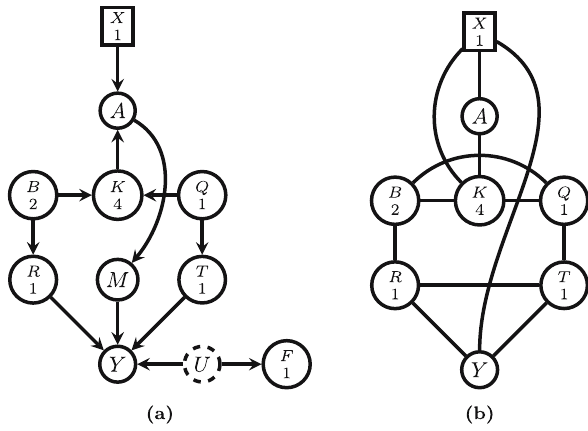
Figure 2: A directed acyclic graph (cid:3) ( a ) and the undirected graph 1 (cid:2) associated with it ( b